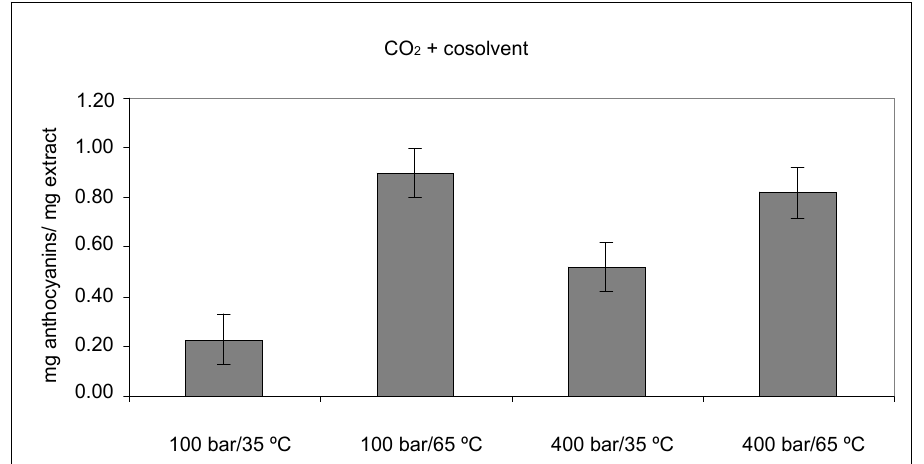
Figure 2. Anthocyanin concentration of extracts obtained by SFE at different pressures and